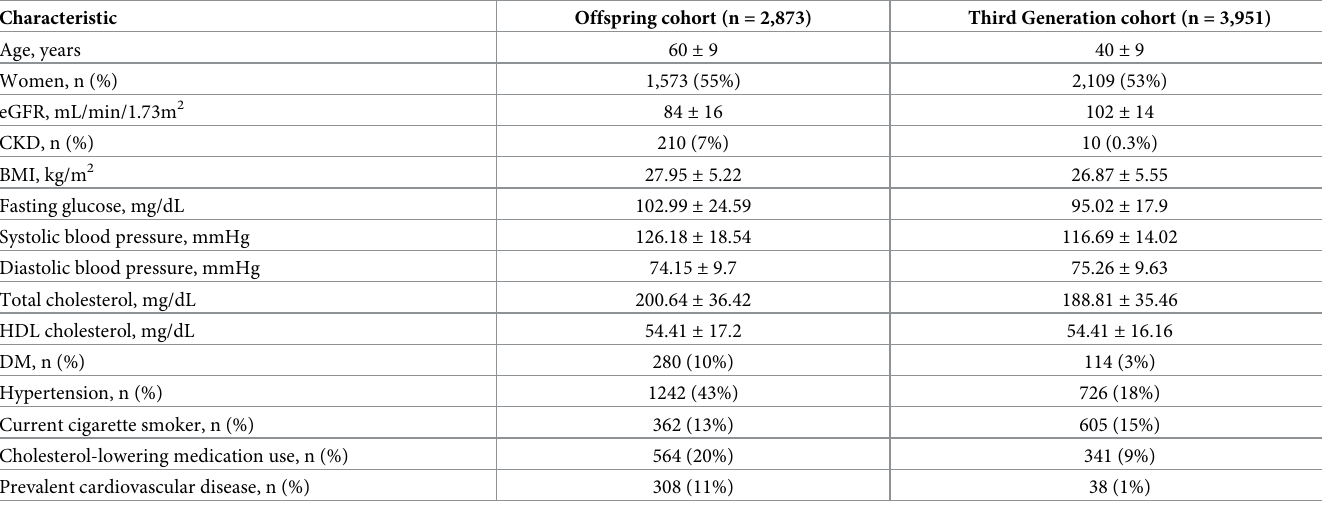
Table 1. Baseline demographic and clinical participant